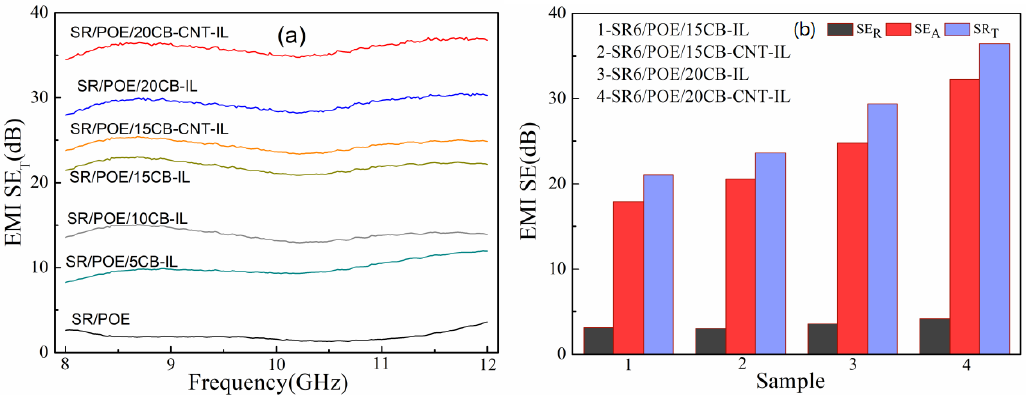
Figure 3. ( a ) Electromagnetic interference shielding e ff ectiveness (EMI SE) of the SR / POE / CB-IL and SR / POE / CB-CNT-IL composites in the frequency range of 8.0 to 12.0 GHz, and ( b ) comparison of SE T , SE A , and SE R of the SR / POE / CB-IL and SR / POE / CB-CNT-IL composites at 9.0